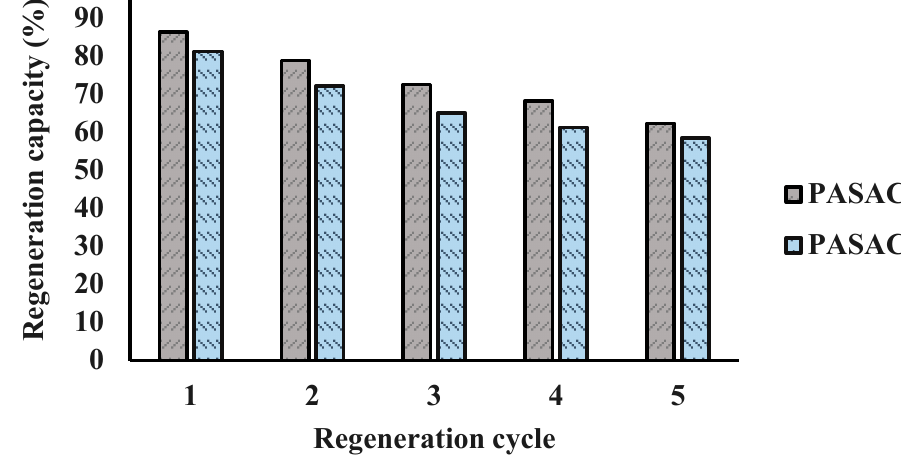
Figure 7. Regeneration capacity of PSAC23 and PSAC35.